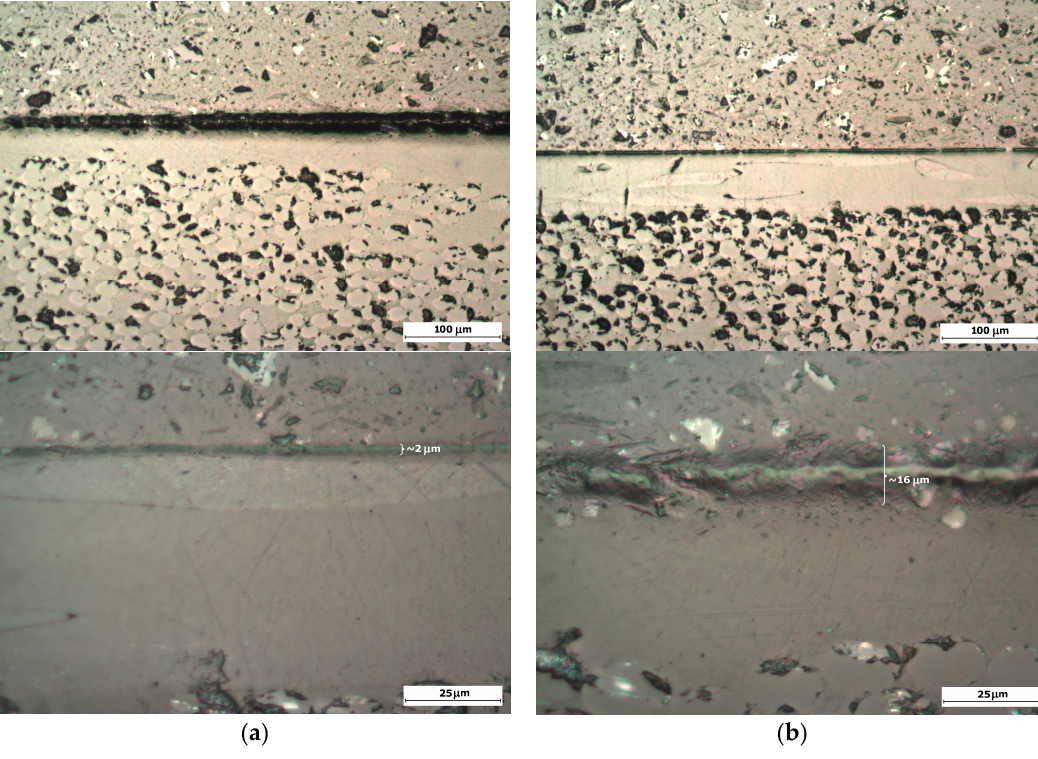
Figure 20. ( a ) Microscopy samples for interphase chemical adhesion: Coat 1, (Cured) and ( b ) Coat 2, (Semi-cured). Upper images magnification 100×, lower images are 400×). Table 2. Bulk properties obtained from gel coating configuration nanoindentation testing.